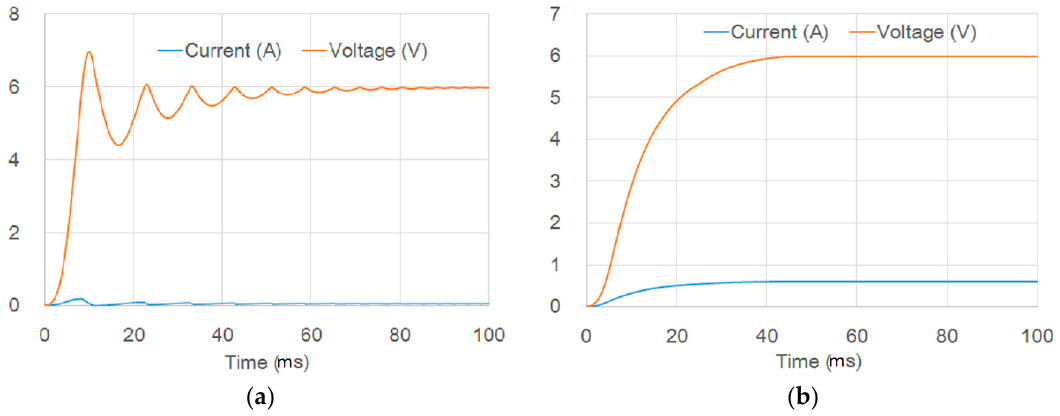
Figure 16. Simulation voltage and current waveforms with ( a ) small load and ( b ) increased load.